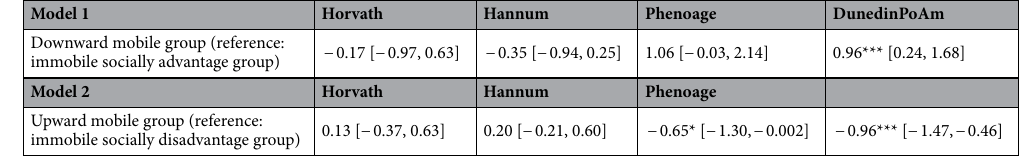
Table 7. Ordinal linear regression estimates [95% confidence interval] for association of mobility vs immobility with accelerated age assessed with Horvath, Hannum, Phenoage and DunedinPoAm for two comparisons. Model 1; downward mobile group vs immobile socially advantaged group. Model 2; upward mobile group vs immobile socially disadvantage group. All models also controlled sex, standardized age